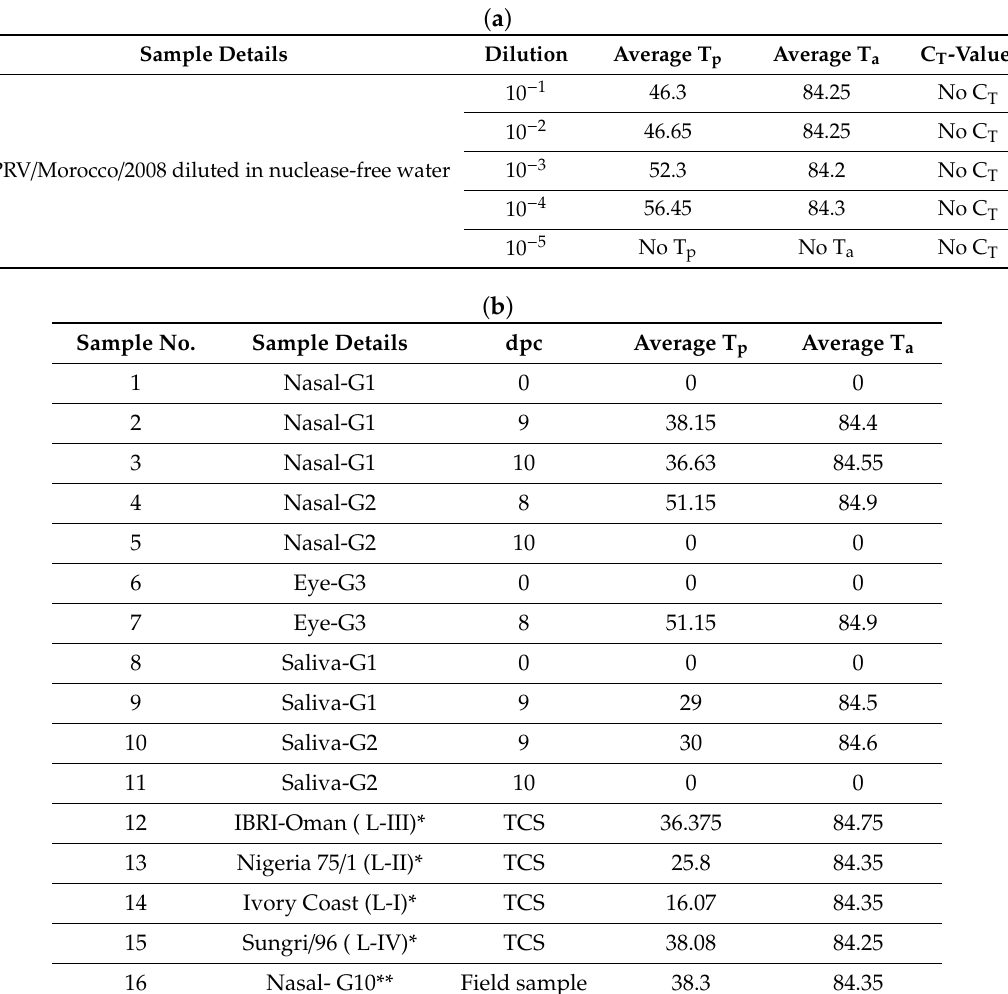
Table 4. ( a ) Results of RT-LAMP assay and RT-qPCR using viral samples without prior RNA extraction. T P : Time to positivity, T a : Anneal temperature, C T : Cycle threshold values. ( b ) Results of RT-LAMP assay using samples without prior RNA extraction. dpc: days post-challenge, T P : Time to positivity, T a : Anneal temperature, TCS: tissue culture supernatant. * indicates cell culture supernatant, **